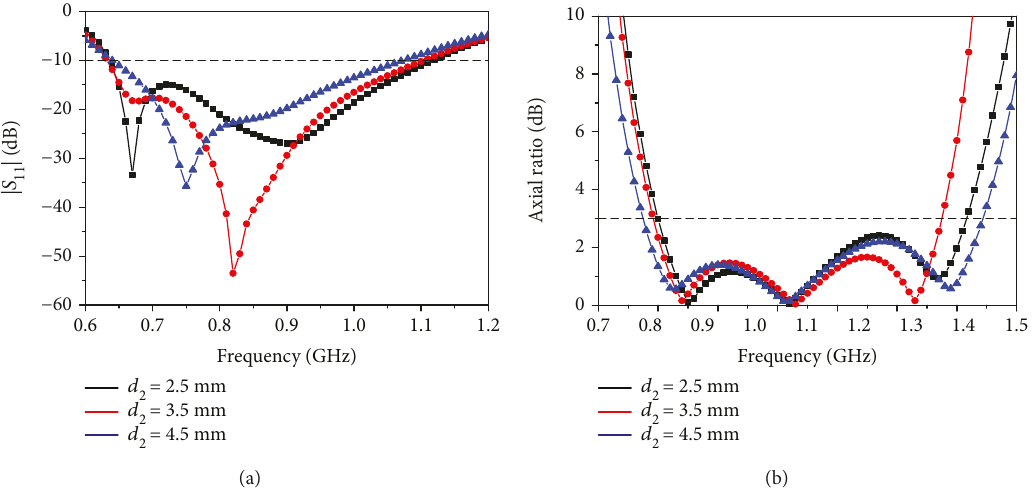
ff erent distances ( d